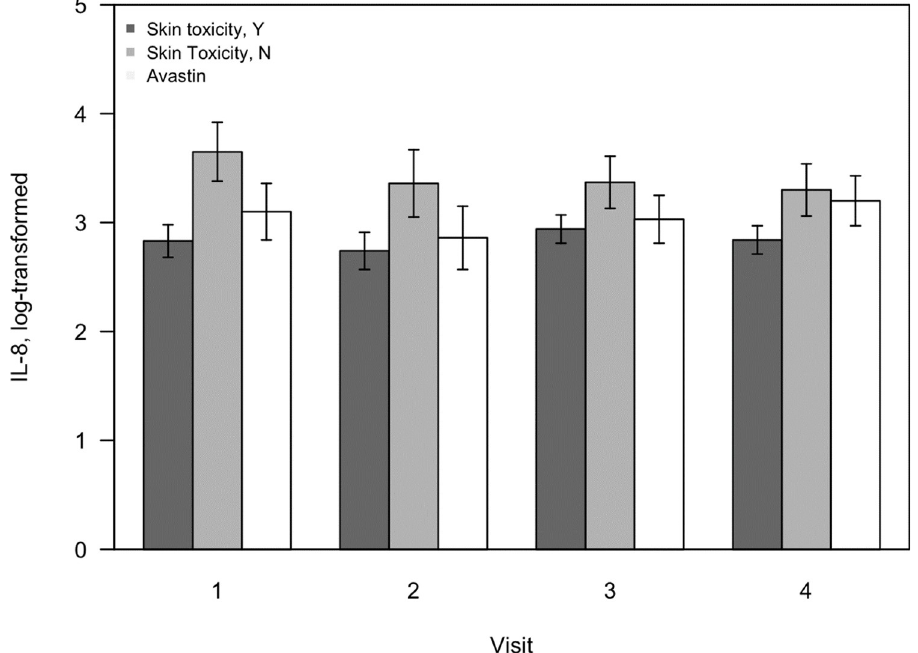
Fig 2. The mean log-transformed serum IL-8 level at three time points for each